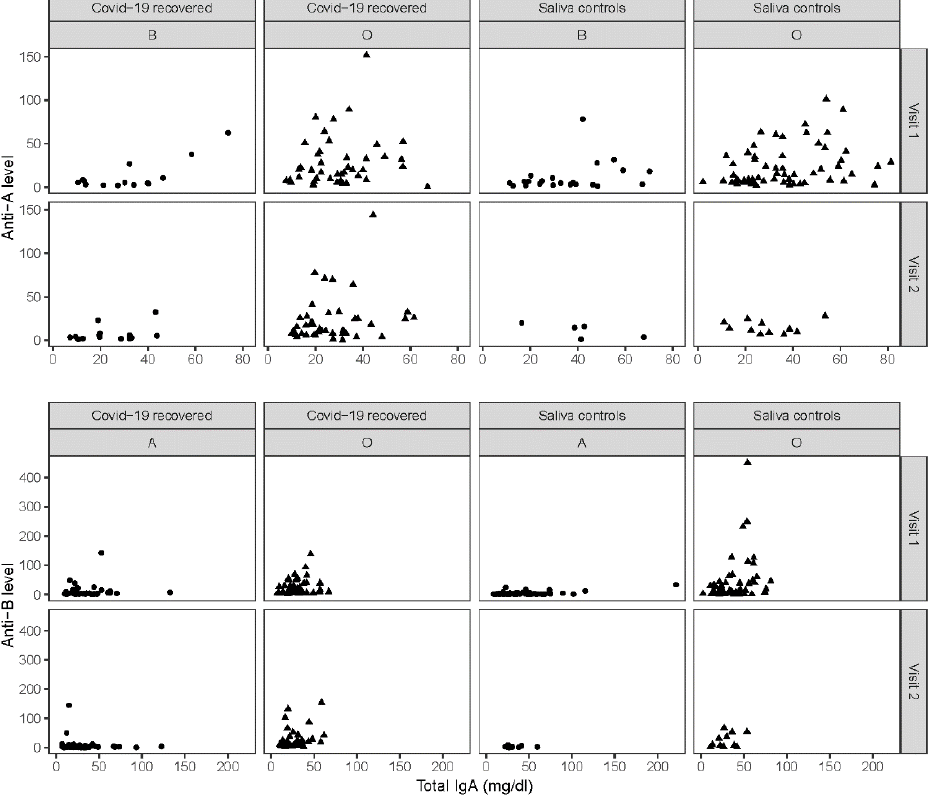
Figure 4. ABO Anti-A- and anti-B-specific IgA analysed in relation to total IgA in saliva. Observations for types A and B are depicted as circles, and those for blood type O are depicted as triangles.